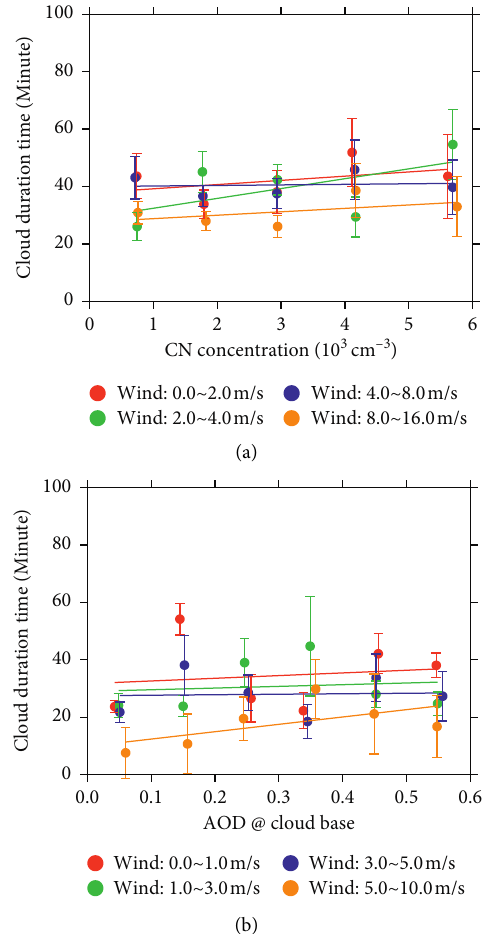
Figure 9: Cloud duration as a function of aerosol loading for different wind speed ranges at the (a) SGP and (b) SACOL sites for single-layer clouds. Error bars show the standard